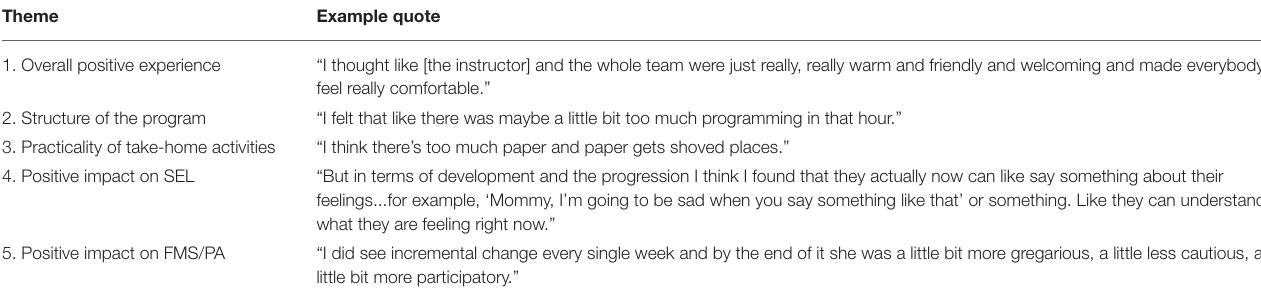
TABLE 7 | Summary of results from the thematic analysis of the focus group.